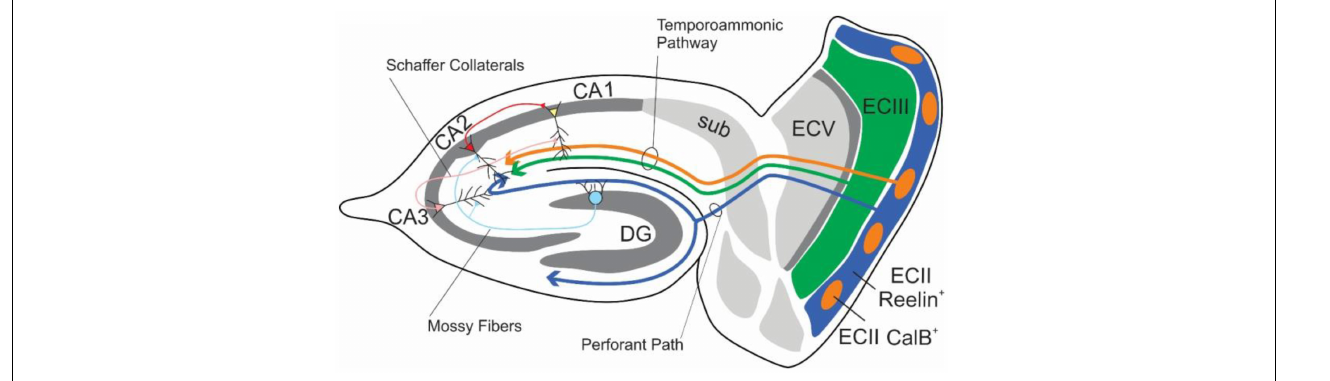
FIGURE 3 | Schematic diagram of the major connections of the EC-HPC network. Axons from the EC layer III and CalB + pyramidal cell clusters in EC layer II project along the temporoammonic pathway (ECIII/ECII CalB + → CA1), which largely governs temporal features, The indirect pathway, which is involved in spatial and contextual learning, originates from Reelin + stellate cells within EC layer II and projects to the classical tripartite synapse (ECII Reelin + → DG → CA3 → CA1). Additional connections from DG to CA2, and CA2 to CA1 exist alongside the more heavily studied hippocampal pathways.